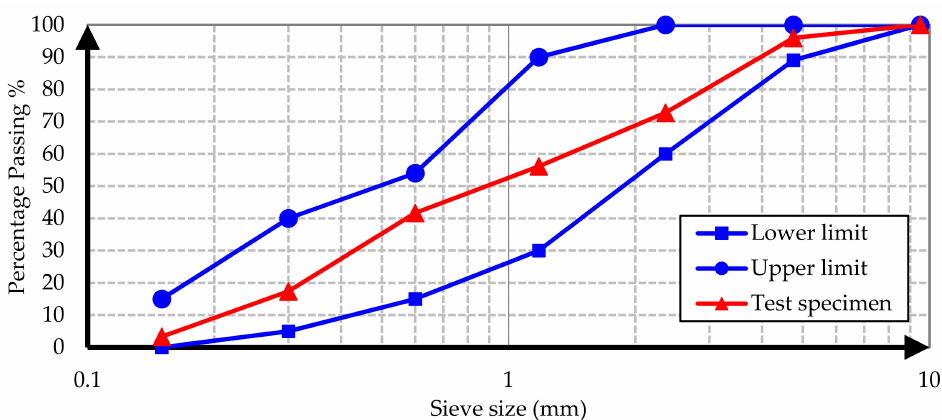
Figure 2. Conventional sand sieve analysis grading